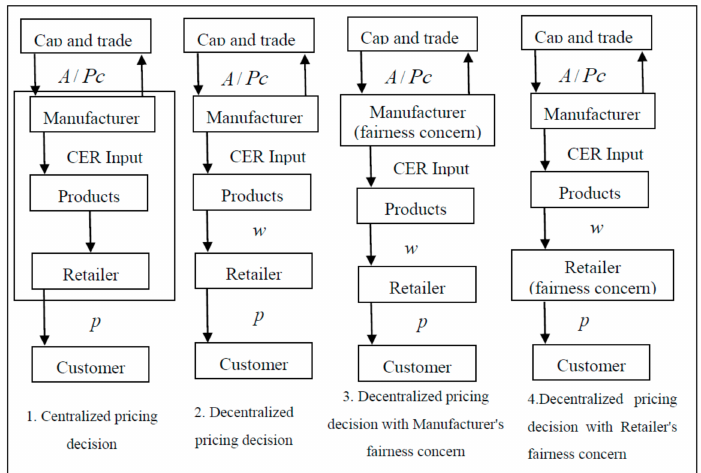
Figure 1. The four cases of pricing decisions.